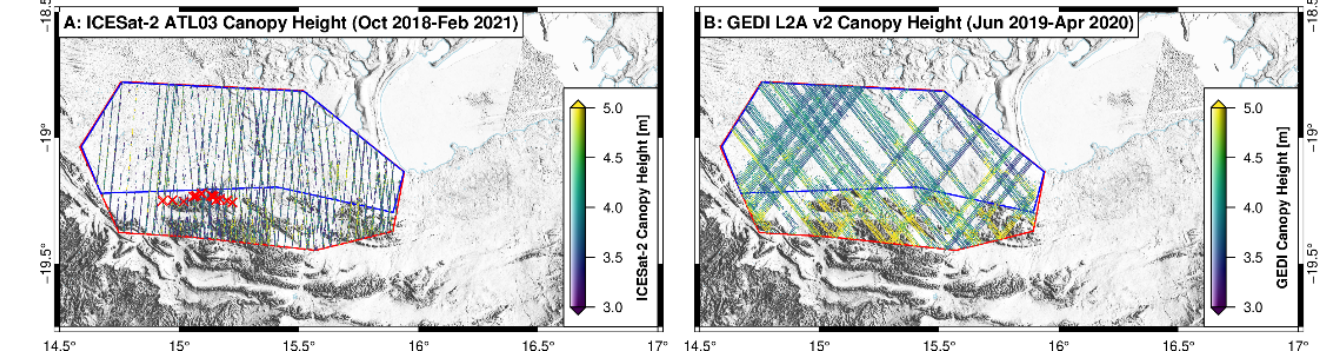
Figure 2. ICESat-2 and GEDI ground tracks for the study region (cf. Figure 1). ( A ) Canopy height derived from the SVDA processed ATL03 data described in this study. Red crosses indicate the 55 field-based tree height measurements of different species for validation. A detailed map of the tree-height field measurements is shown in Supplementary Figure S2. Red polygon outlines study area including more densely vegetated mountainous terrain and blue polygon is limited to the low-slope, sparsely vegetated savanna ecosystem. ( B ) Canopy height measurements taken from GEDI product L2A (version